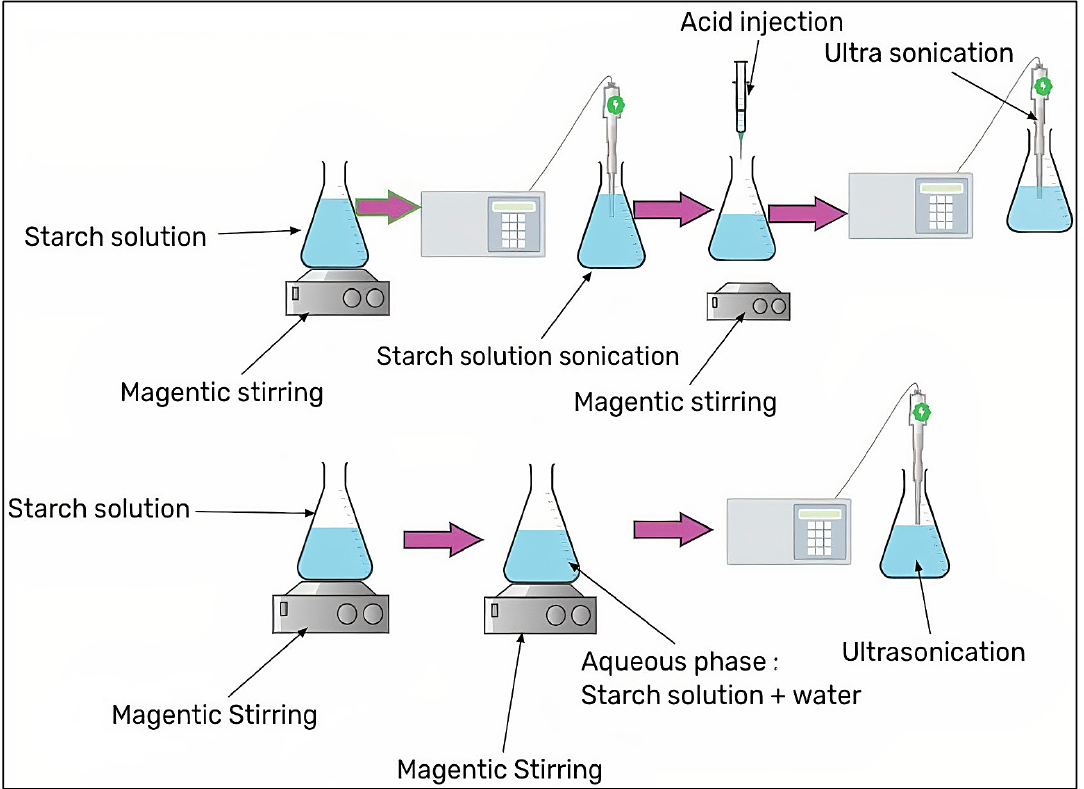
Figure 5. Ultrasonication with/without acid hydrolysis.